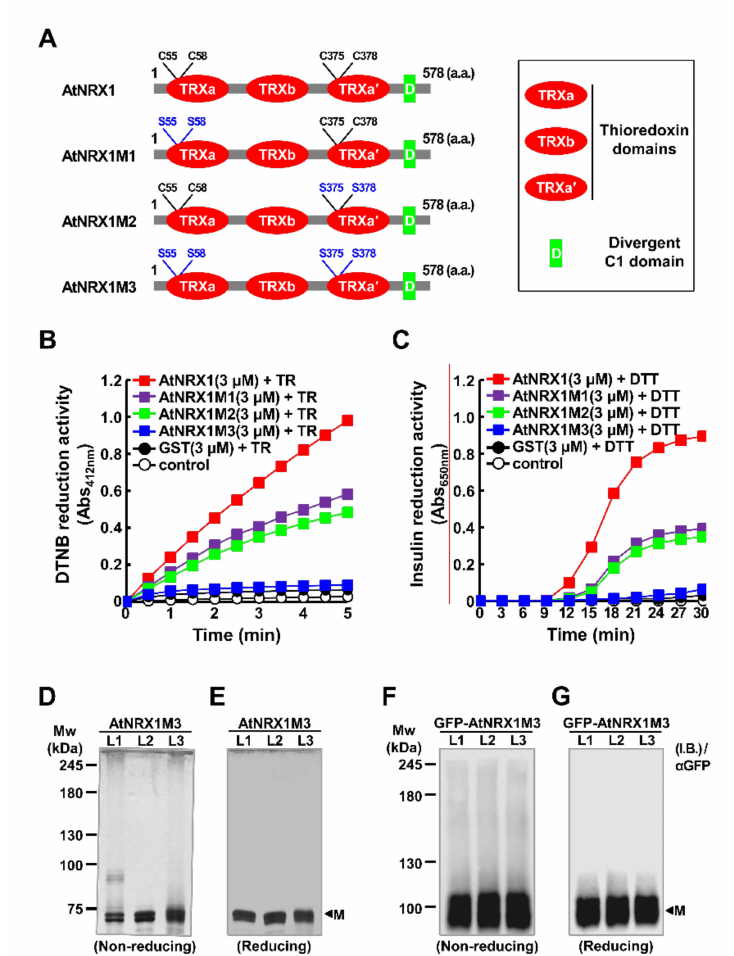
Figure 2. E ff ect of active site Cys residues on the structural and functional properties of AtNRX1. ( A ) Structural depictions of the wild-type (WT) and mutant AtNRX1s. Three TRX domains (TRXa, TRXb, and TRXa (cid:48) ) and one DC1 domain are depicted. The active site Cys residues and the substituted serine (Ser) residues of AtNRX1s are indicated in black and blue, respectively. ( B , C ) Disulfide reduction activity of the WT and mutant AtNRX1s using 5 mM DTNB ( B ) and insulin ( C ) as substrates. In ( B